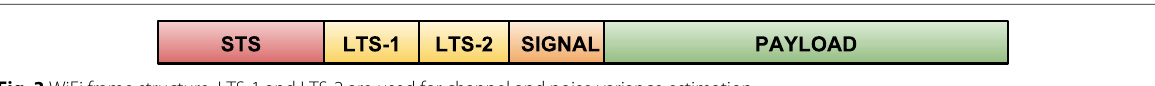
Fig. 3 WiFi frame structure: LTS-1 and LTS-2 are used for channel and noise variance